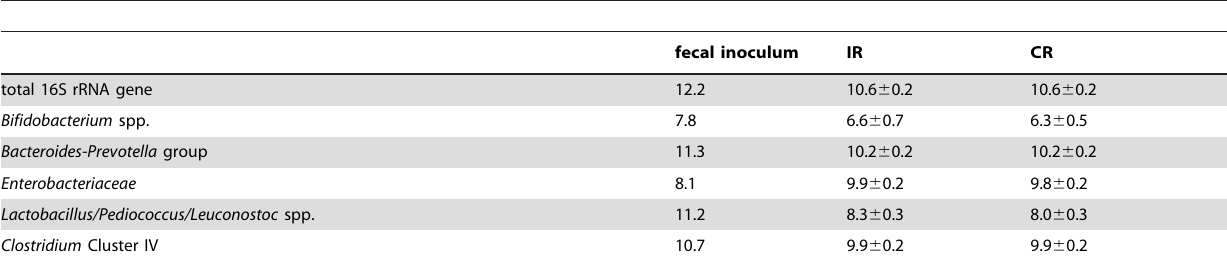
Table 3. Mean concentration (log 10 copy numbers mL 2 1 effluent) of specific bacterial groups measured by qPCR in the fecal inoculum and effluent samples from inoculum reactor (IR) and control reactor (CR) during the stabilized period (d11-54).